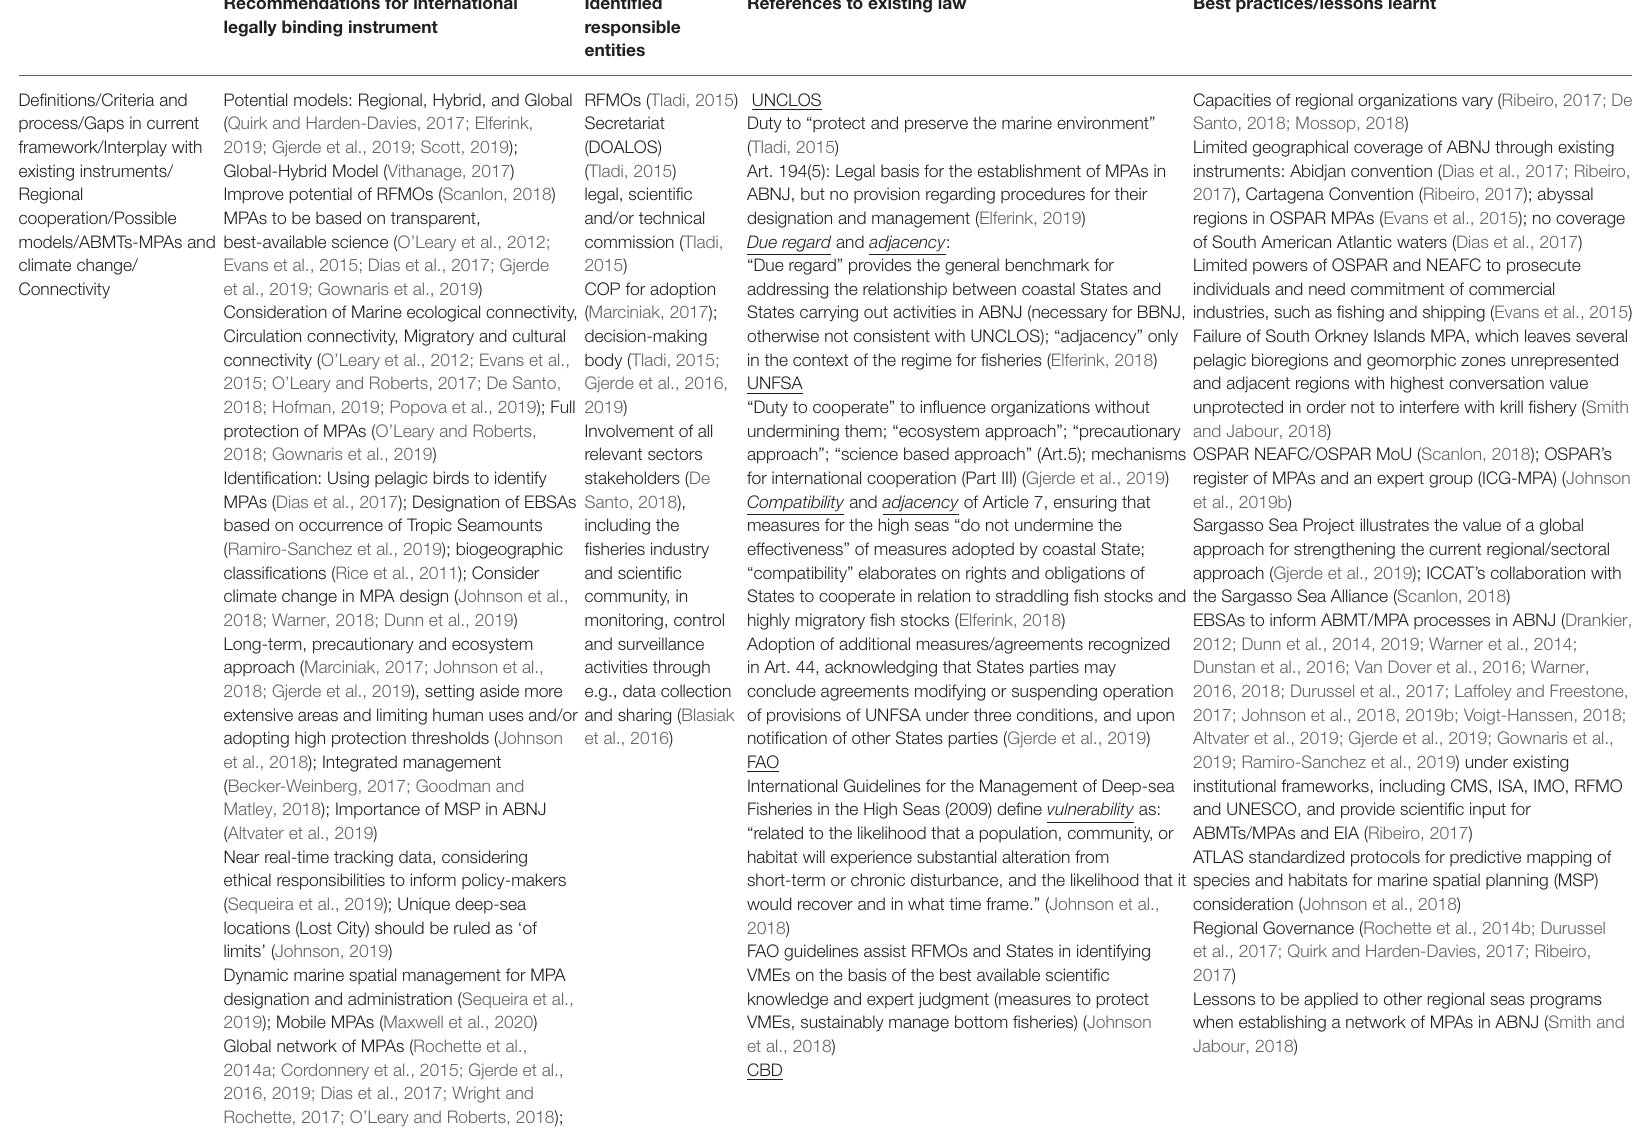
TABLE 4 | ABMT/MPA BBNJ